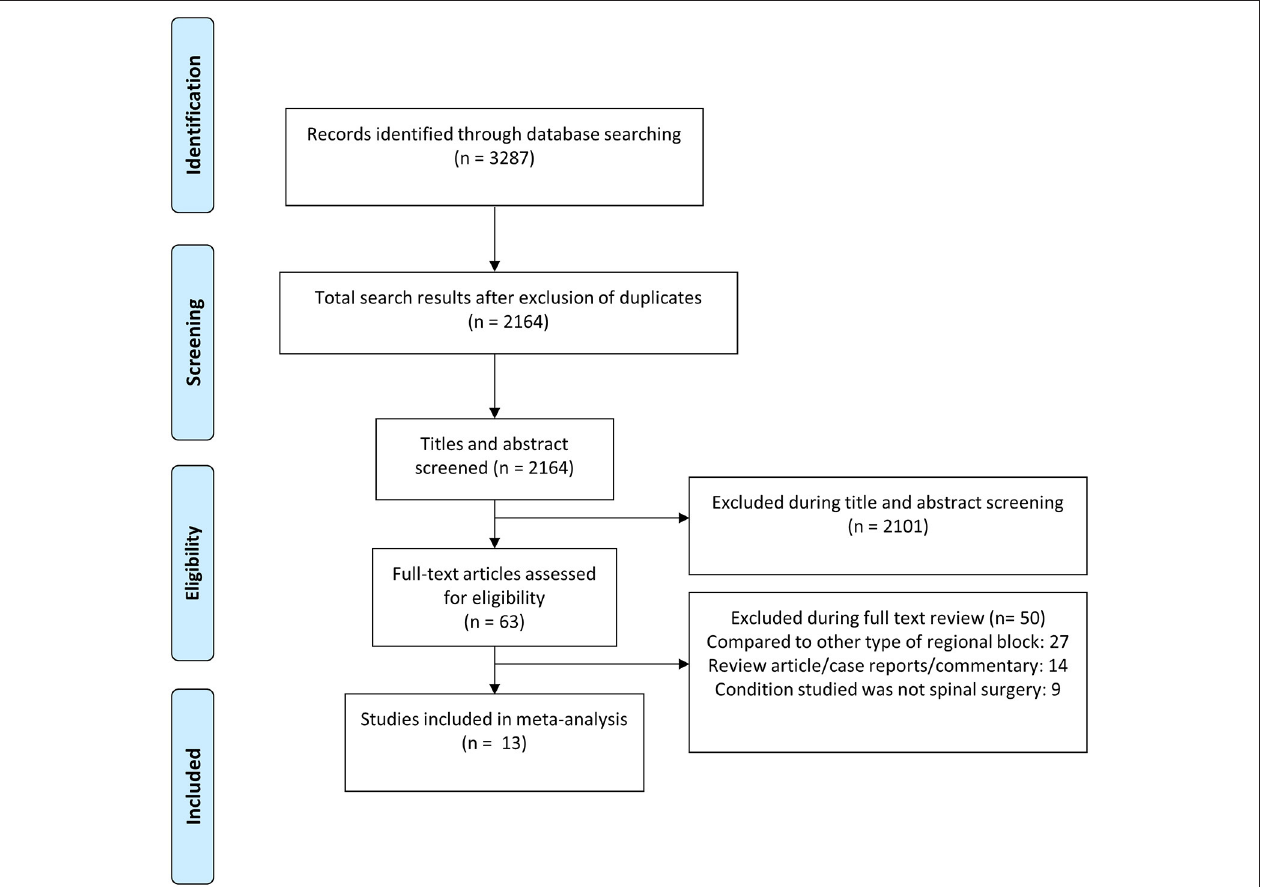
FIGURE 1 | Selection process of the studies included in the review.